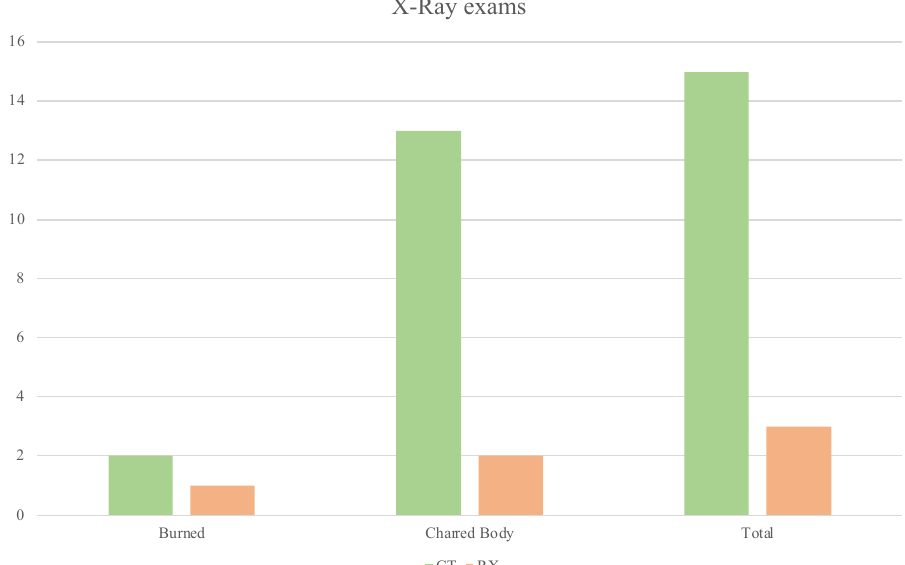
Figure 6. The chart shows the radiological investigations performed on the charred bodies and those with different burn degrees. Table 3. Results of radiological exams in 82 cases of burned or charred bodies. The presence of fracture, parenchymal lesions, and metallic bodies was investigated.